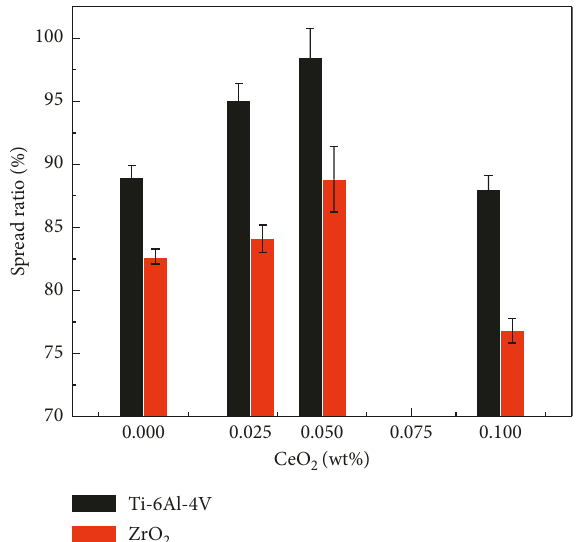
Figure 6: Spreading ratio of various Ag-Cu-Ti- x CeO